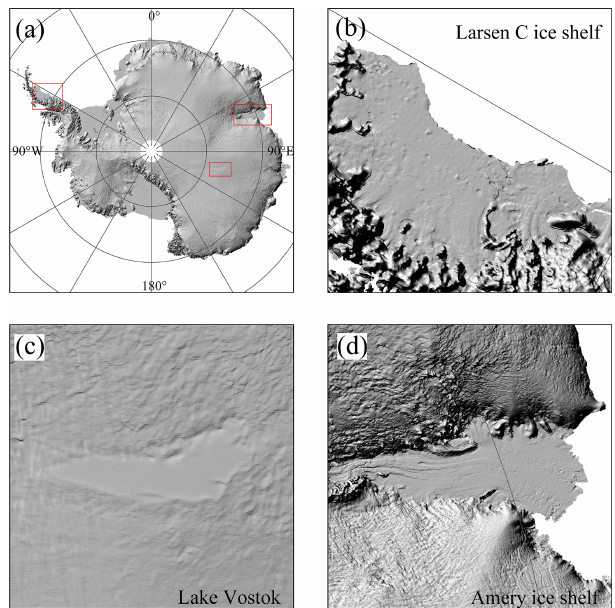
Figure 7. (a) Shaded relief map of Antarctica derived from the ICESat-2 DEM. The detailed maps of the Larsen C ice shelf, Lake Vostok and Amery ice shelf are shown in (b) , (c) and (d) , respec- tively, and their locations are also shown in (a) by red rectangular